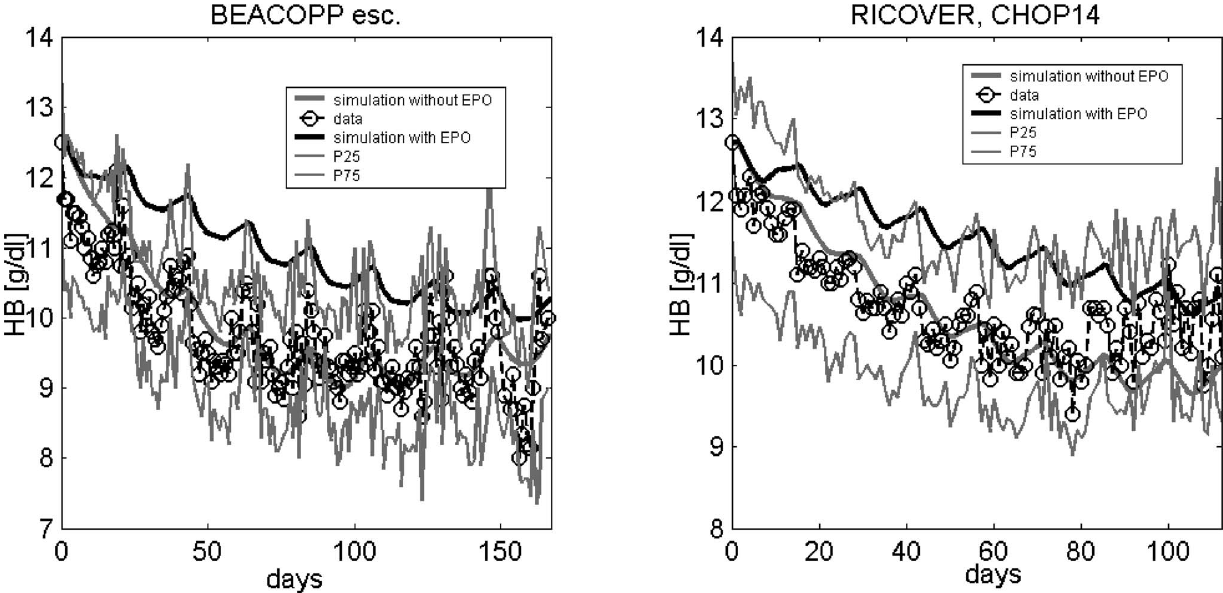
Figure 11. Prediction. Weekly administration of 150 IU/kg Darbepoetin Alfa has the potential to avoid anaemia in patients treated with 8 cycles of BEACOPP-21 escalated (left) or CHOP 14 (right).